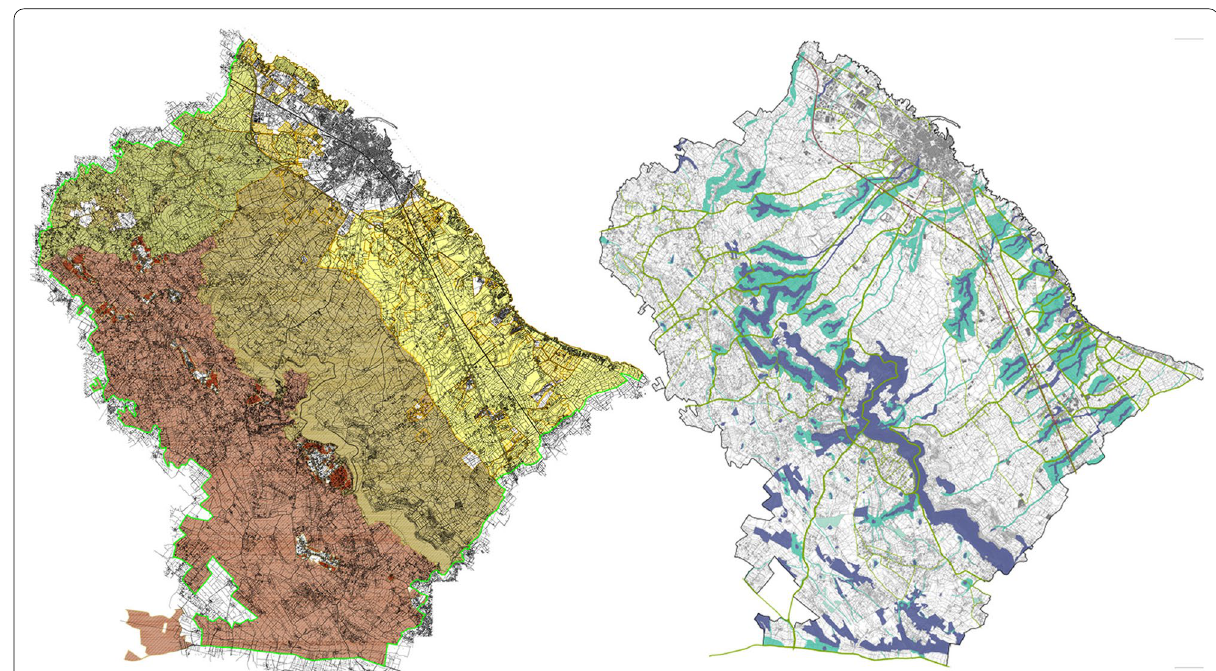
Fig. 9 The City-Country Pact strategy. The strategy of the City-Country Pact on the left interprets the vast rural territory of Monopoli into different areas of the Multifunctional Agricultural Valorisation Park. The perimeters depend on the density of archaeological and rural heritage, the density of monumental olive trees and the presence of historic rural settlements. While the strategy on the left shows the Municipal Ecological Network. Source: Municipality of Monopoli, extracts from tables 27_PUG_S_13i (original content scale 1:15,000, north–south oriented) and 57 (original content scale 1:15,000, north–south oriented) of the Adaptation of the Municipal Plan to the PPTR